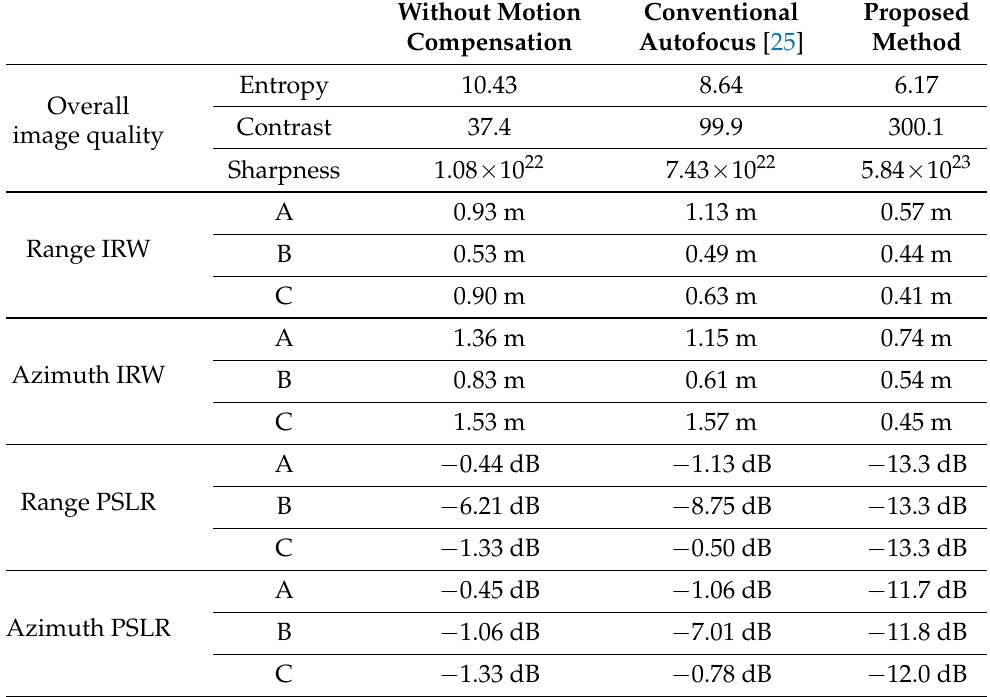
Table 2. Simulation